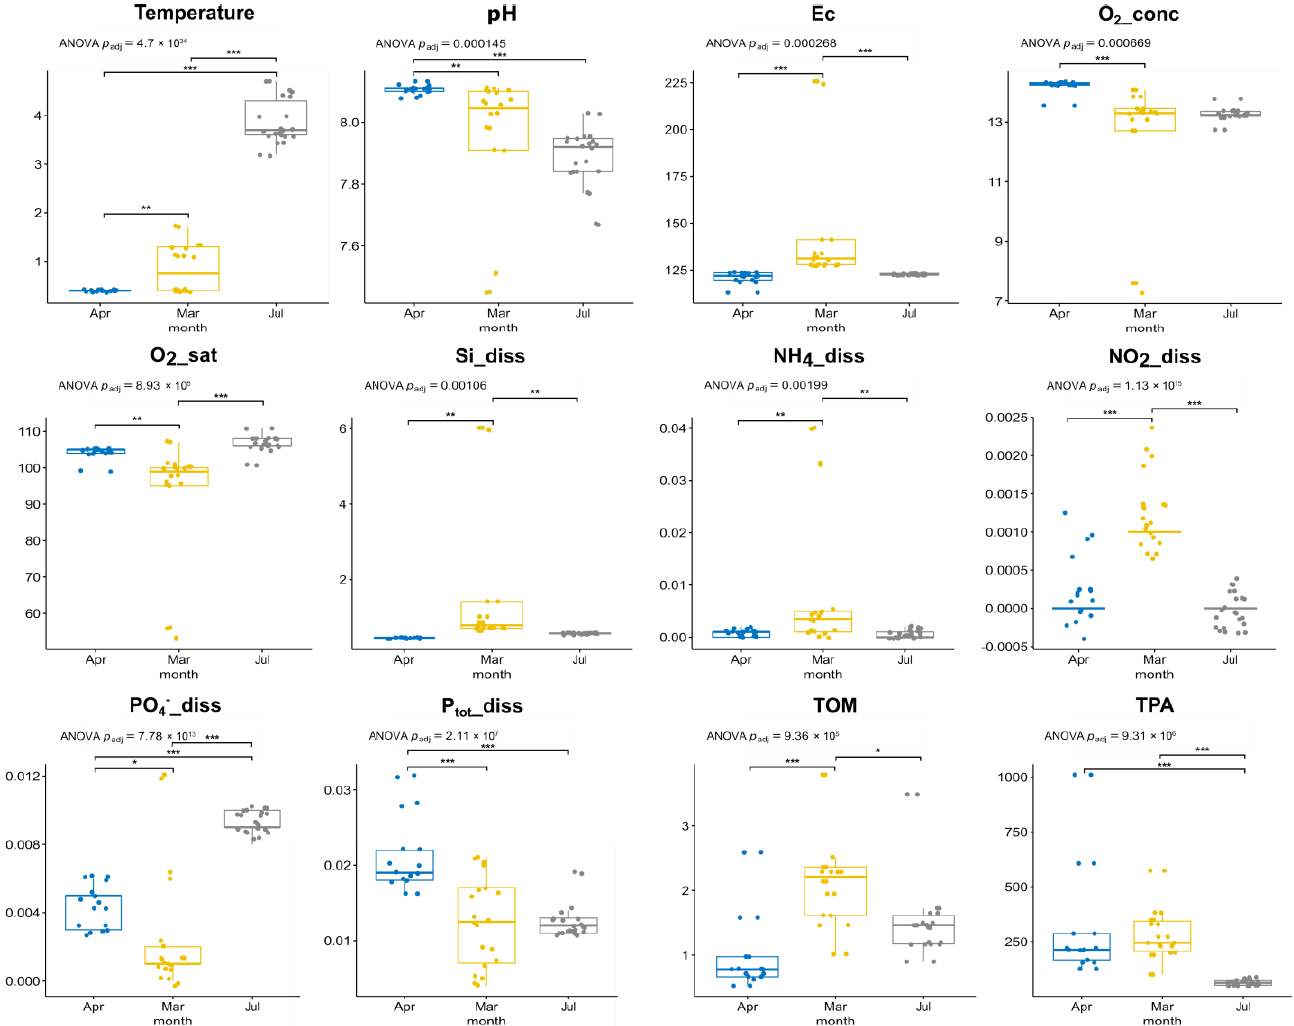
Figure 2. One-way ANOVA computed for environmental variables. Significance code of Tukey’s post hoc tests: *** ≤ 0.001; 0.001 ≤ ** ≤ 0.01; 0.01 ≤ * ≤ 0.05.